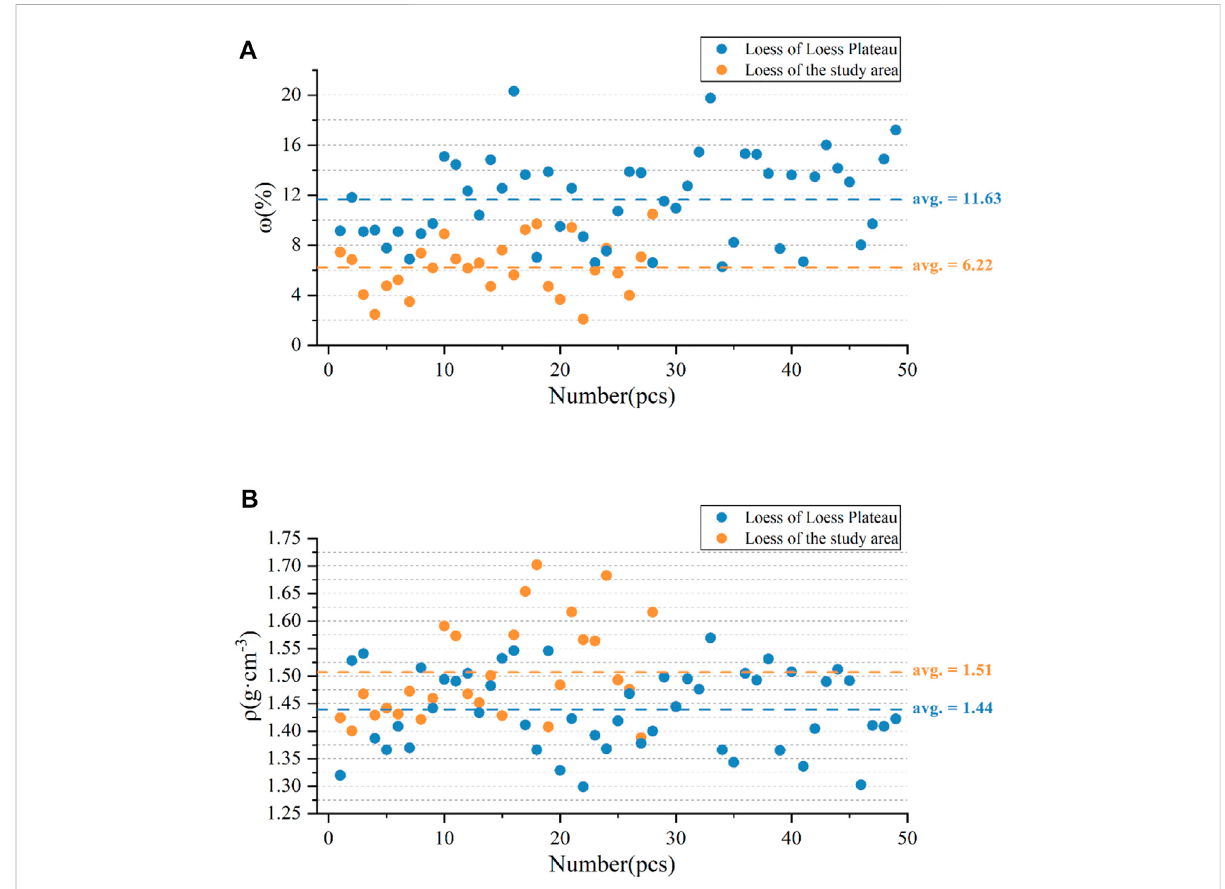
FIGURE 13 The comparison of soil sample ’ s physical properties between the study area and the Loess Plateau. (A) Moisture content; (B)